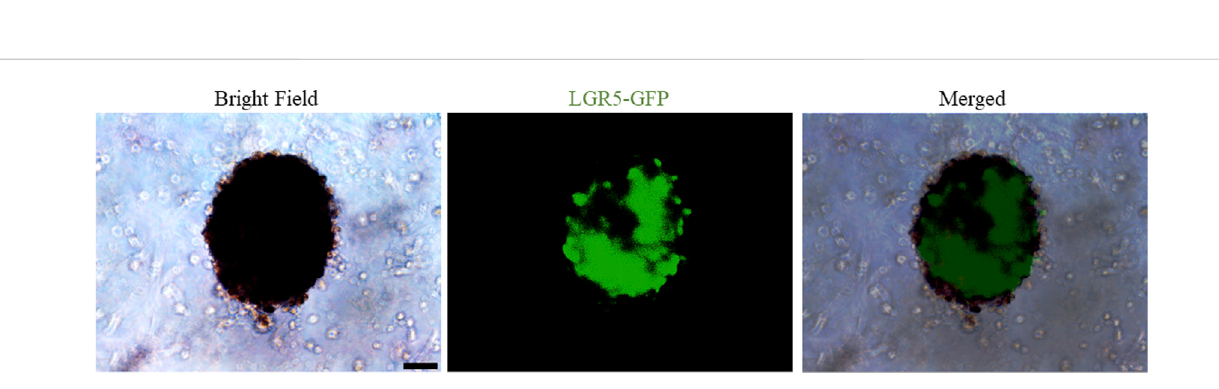
Frontiers in Cell and Developmental